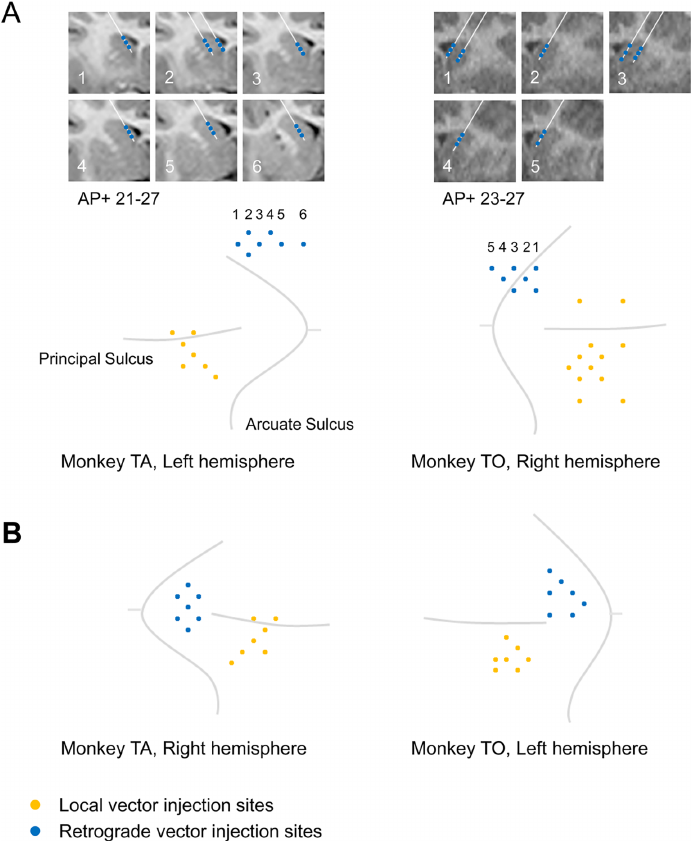
Fig 3. Anatomical location of insertion sites for the two monkeys. Distribution of insertion sites in the LPFC-Cd pathway (A), and in the LPFC-FEF pathway (B). The yellow circles represent insertion sites of local vector (AAV5 for the both monkeys). The blue circle represents insertion sites of retrograde vectors (AAV9 for Monkey TA; HiRet for Monkey TO). Three different depths along each injection track in the Cd were indicated by the blue circles on the T1 weighted anatomical images